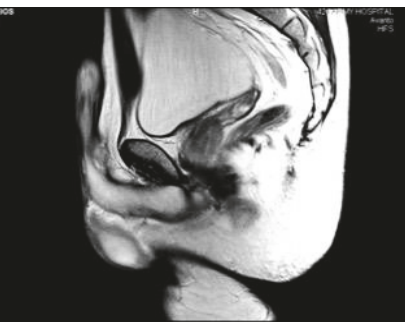
Figure 3: MRI of the penis T2 coronal. Dorsolaterally located nodule:clearlyseparatefromtunicaalbugineabutincludedinBuck’s fascia.